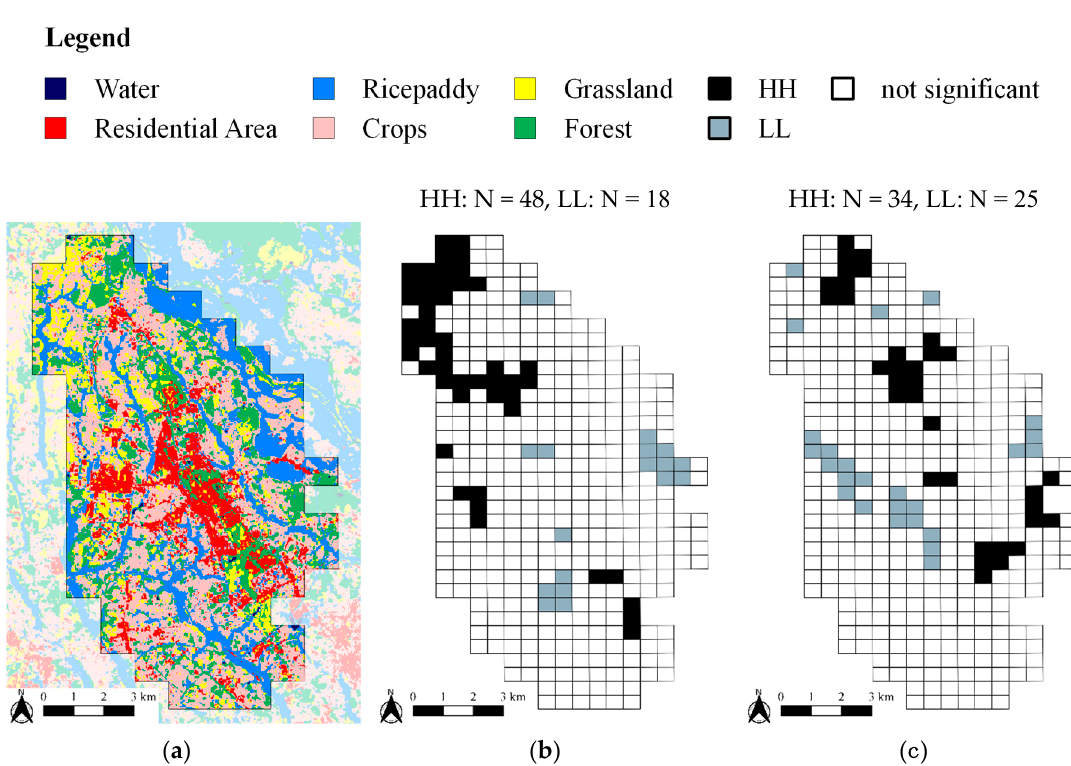
Figure 3. ( a ) Land cover distribution and significant high–high (HH) and low–low (LL) grids in ( b ) Grassland and ( c ) Forest in the 2010s. In ( a ), translucent were not included in our study site. HH means statistically significant high–high grid. LL means statistically significant low–low grid. In this study, there is no statistically significant low–high or high–low grid. A p -value less than 0.05 was considered statistically significant.